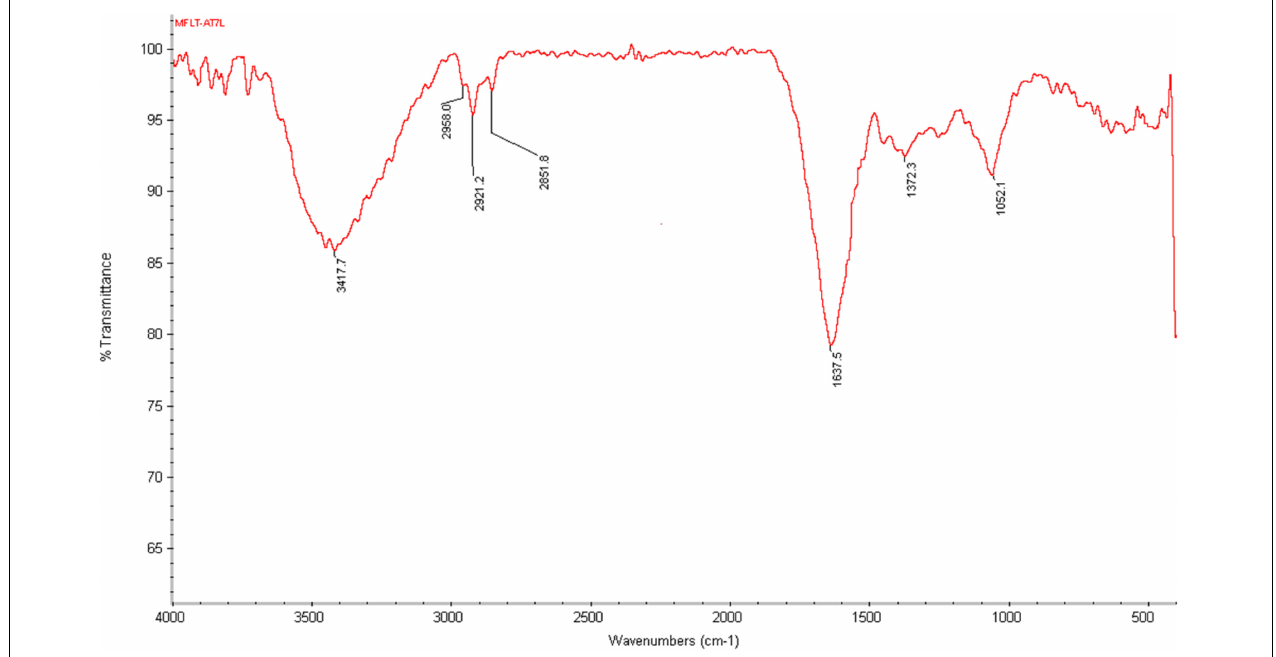
FIGURE 8 | Characterization of AgNPs by Fourier-transform infrared (FTIR) of P. variotii